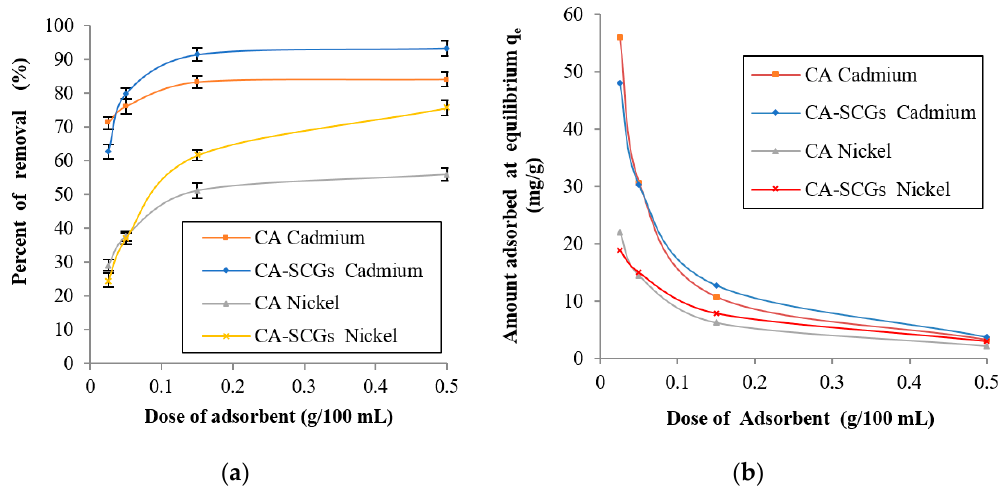
Figure 8. Effect of adsorbent dose at a concentration of 20 ppm of metal at 24 h: ( a ) % of removal of metal and ( b ) Amount adsorbed at equilibrium ( q e ).